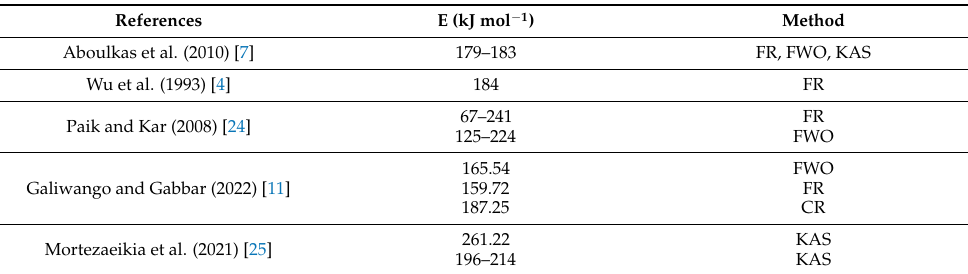
Table 7. Activation energies of PP obtained by different published